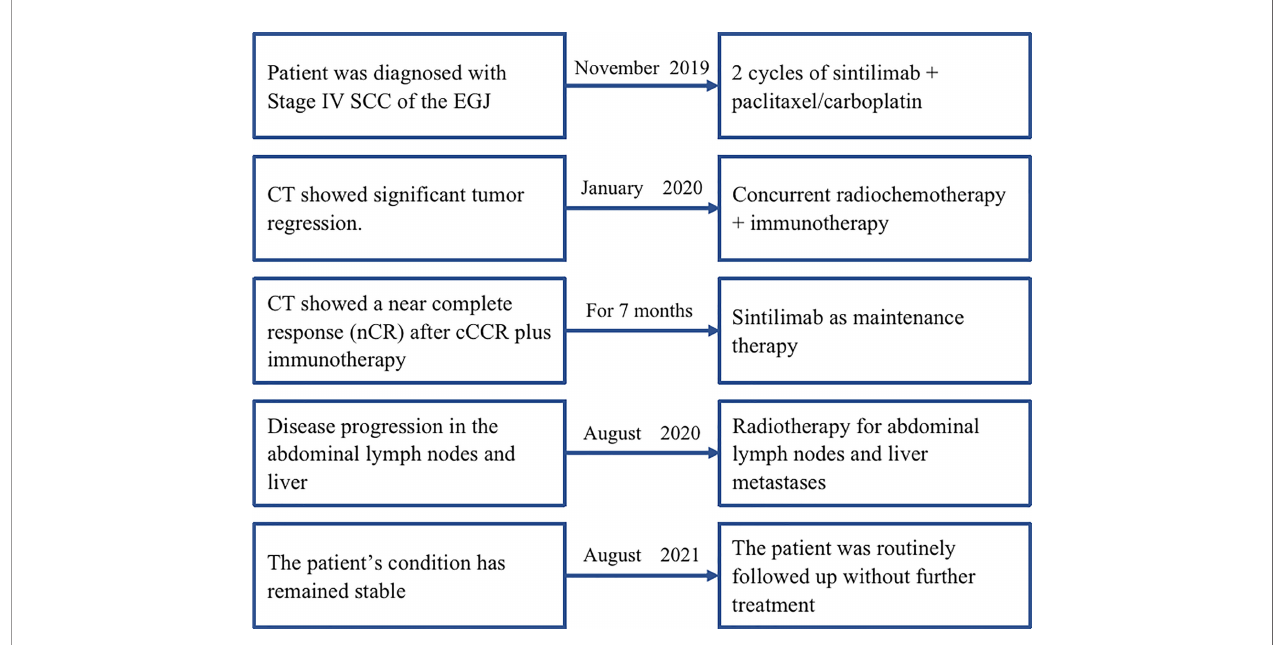
FIGURE 4 | The timeline of diagnosis, interventions, and outcomes ofcase 2. SCC, squamouscellcarcinoma; EGJ, esophagogastric junction; CT,